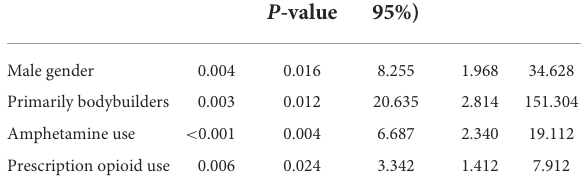
TABLE 4 Binary logistic regression of factors associated with having used anabolic androgenic steroids the last year compared to participants reporting not using anabolic androgenic steroids the last